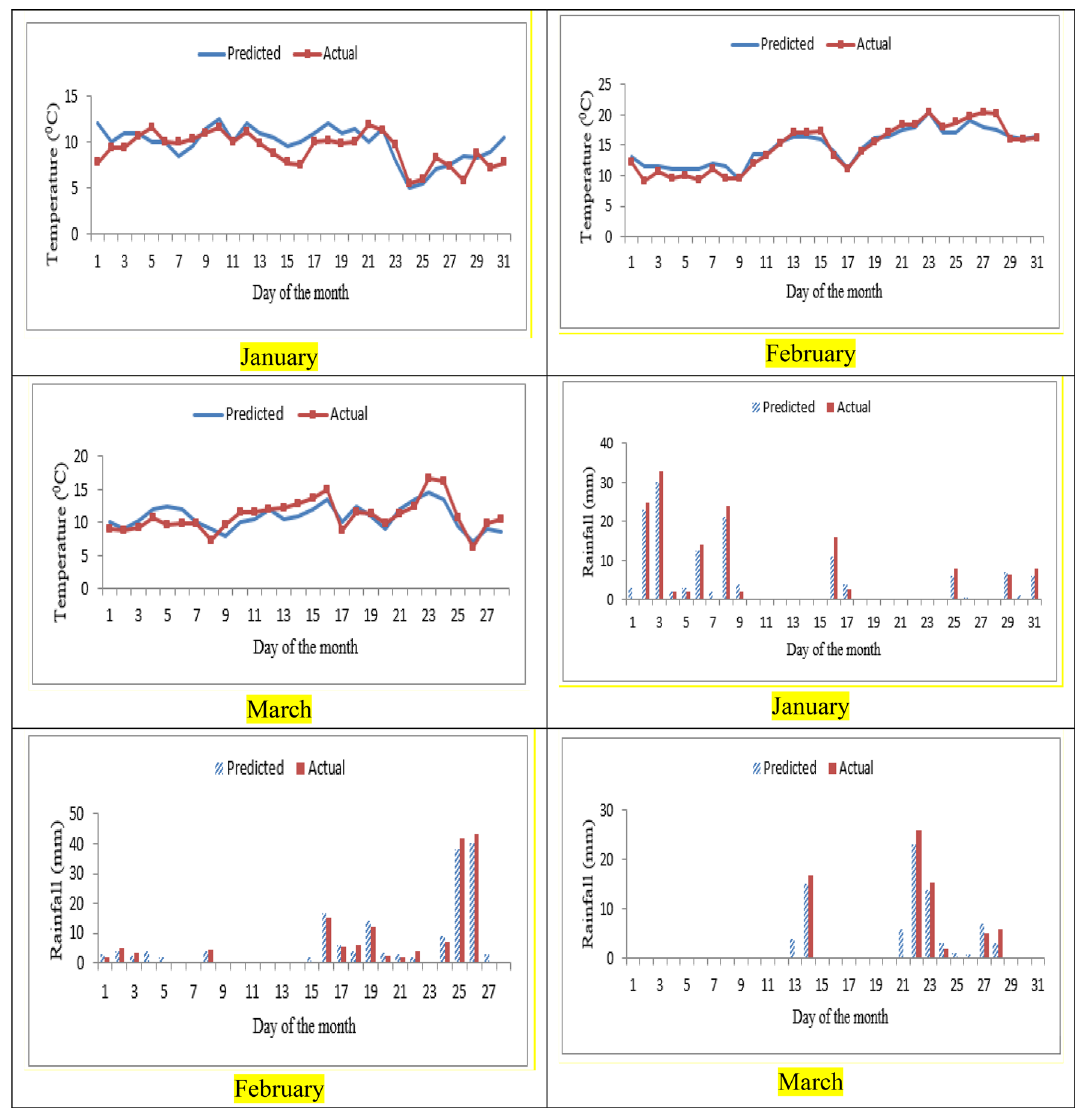
Fig. 10 Plot of actual and predicted temperature and rainfall comparison for Saidu Sharif station. Data Source : Regional Meteorological